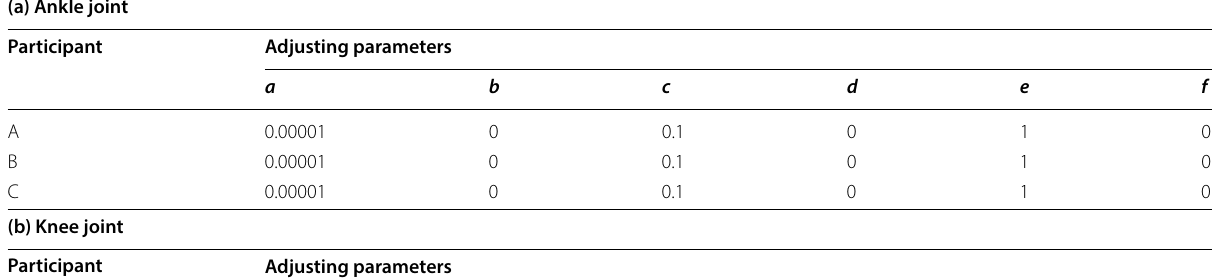
Table 2 Adjusting parameters of NBS in the walking experiment (a) Ankle joint